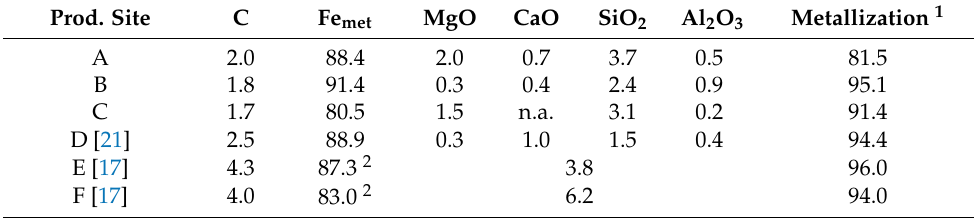
Table 1. Typical direct reduced iron (DRI) compositions (in wt